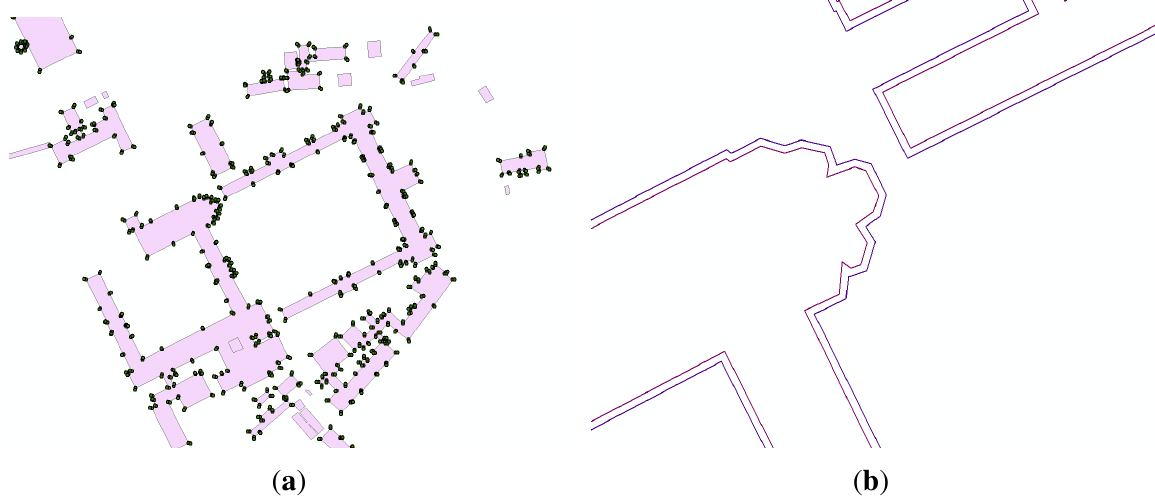
Figure 6. Processing the 2D vector polygons ( a ) identifying the X ,Y coordinates of each building polygon vertex ( b ) applying a 1 m offset to the polygons to aid in triangulated irregular network